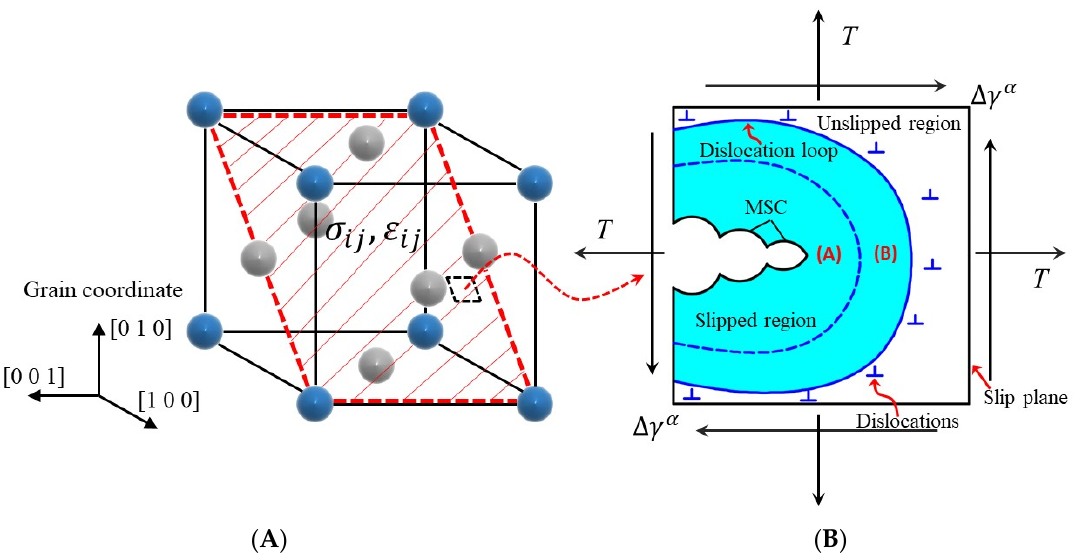
Figure 3. Propagation of microstructurally small crack: ( A ) fatigue damage region, ( B ) cyclic plastic region.